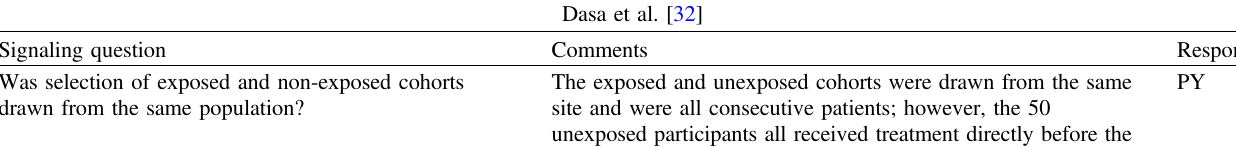
Table 4. ROB assessment for retrospective chart